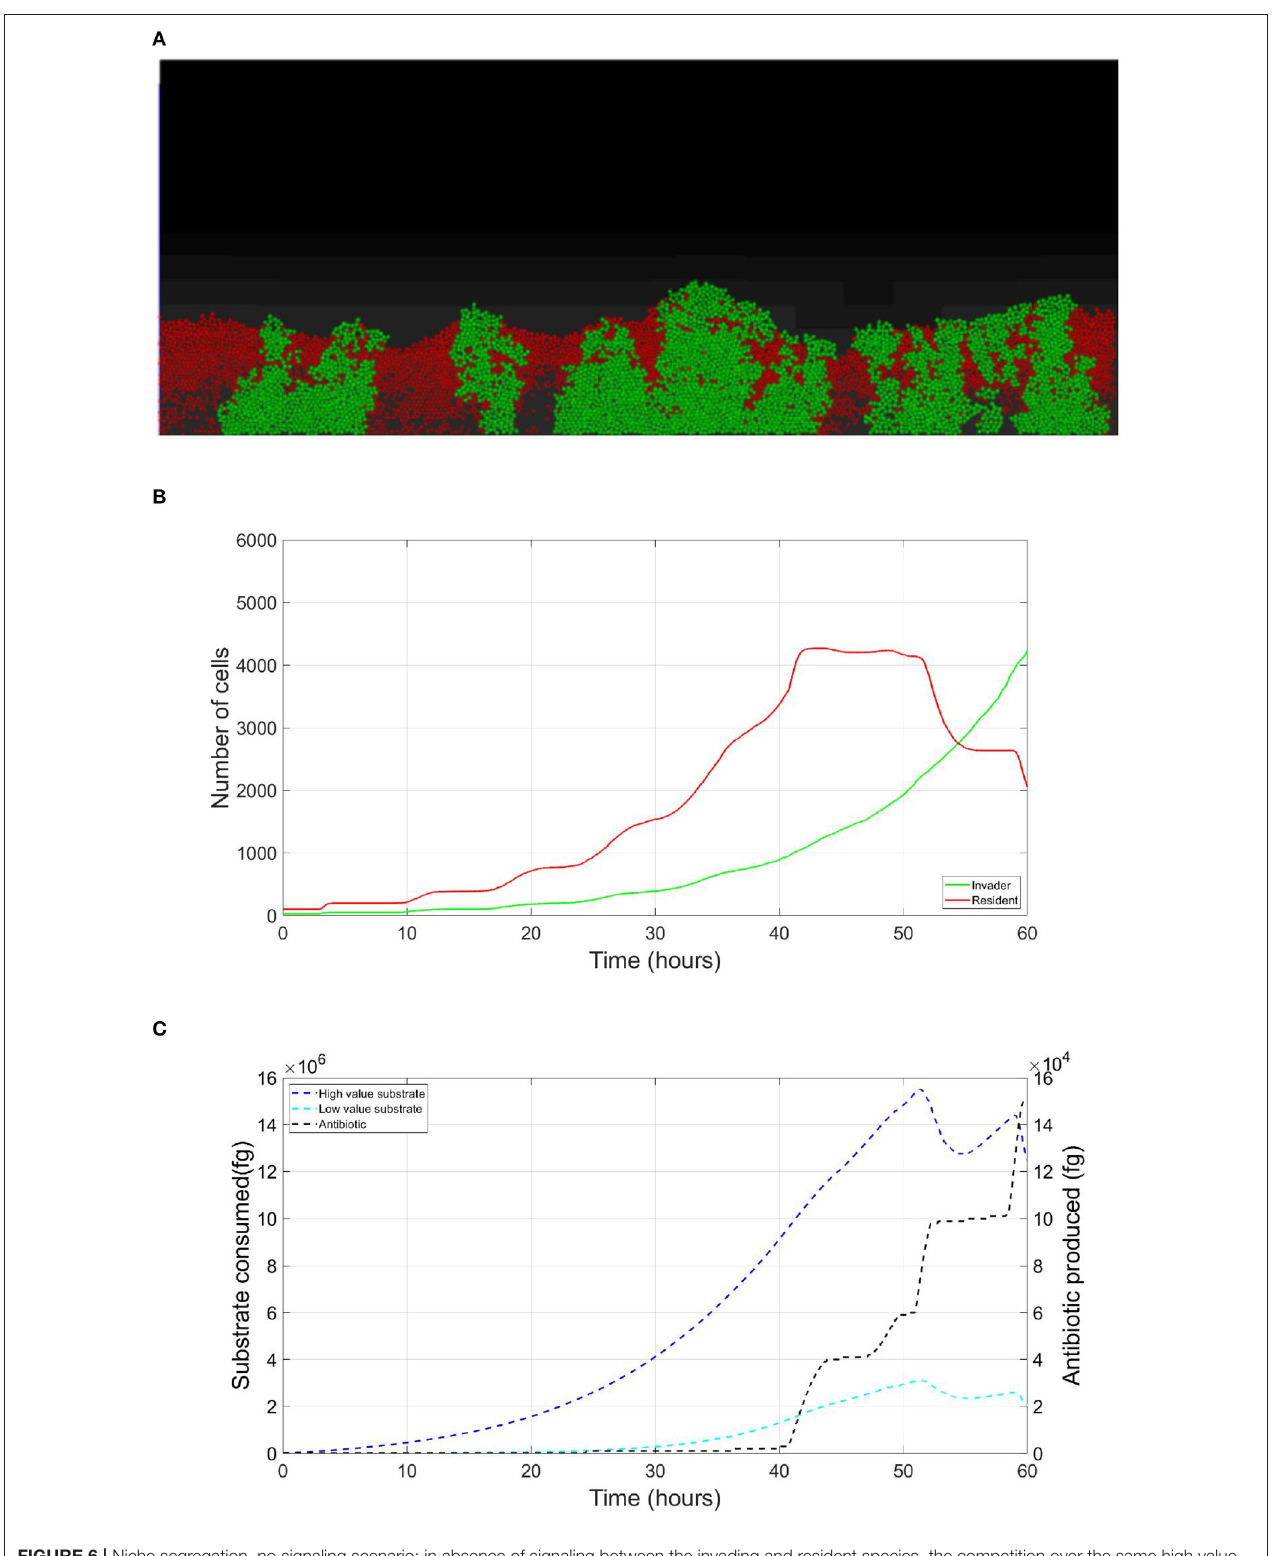
FIGURE 6 | Niche segregation, no signaling scenario: in absence of signaling between the invading and resident species, the competition over the same high value nutrient leads to triggering nutrient stress antibiotic release, which damages the population of the resident species at a cost to the invader species. (A) A snapshot of the competition between the invader species (green) vs. the resident species (red), by the end of the simulation. (B) The evolution of the population of an antibiotic producing invader and a resident species, competing over a common resource. (C) The evolution of the total consumption of the two nutrients as well as the production of the antibiotic by the invader